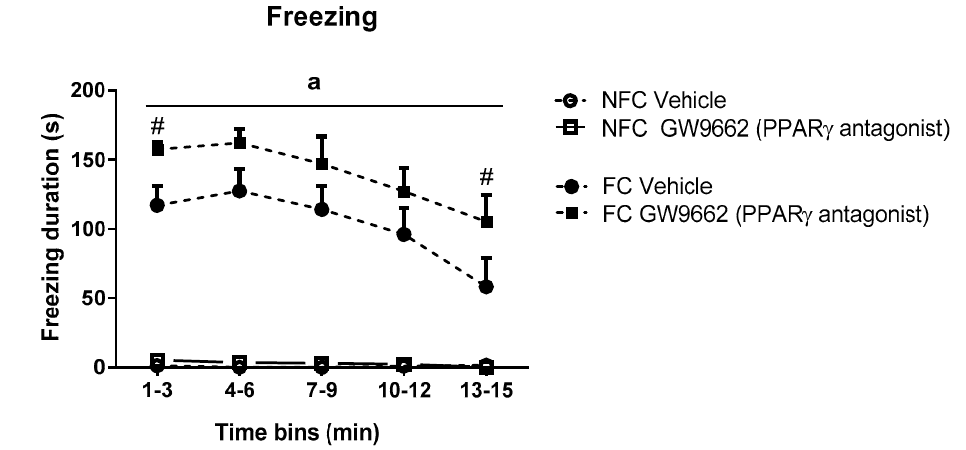
Figure 7. Temporal profile of the effects of systemic administration of selective PPAR γ antagonist on freezing duration in NFC and FC rats. Two ‐ way ANOVA revealed a significant effect of conditioning ( a p < 0.001) on freezing duration. Post hoc analysis revealed that treatment with GW9662 in FC rats significantly affected freezing duration in two time bins (# p < 0.05, vs. FC Vehicle). Data are expressed as 3 min bins (mean ± S.E.M, n = nine rats per group).